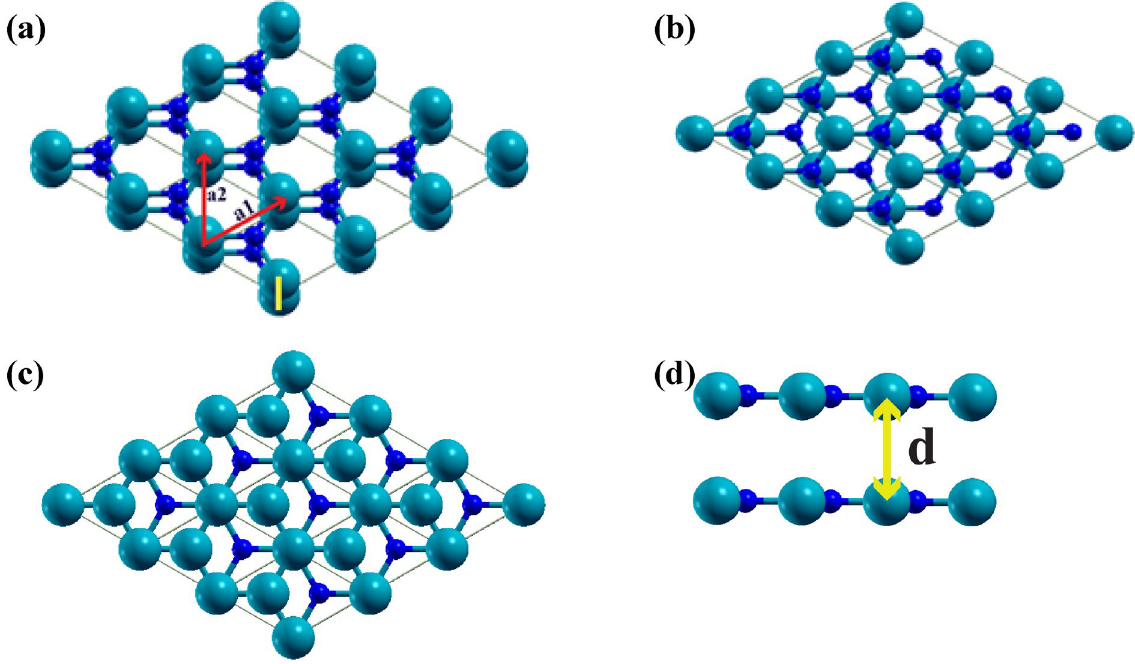
Figure 1. Top view of the ( a ) A–A, ( b ) A–B, and ( c ) A–C stacking patterns. ( d ) Side view of the bilayer showing the interlayer distance ‘d’ between the monolayers. Here, the blue and cyan colors refer to N and In atoms, respectively. a 1 and a 2 denote the in-plane lattice